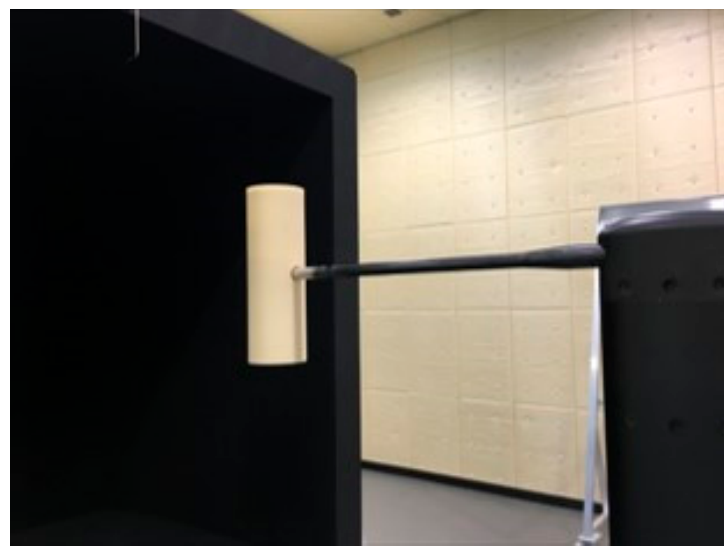
Figure 1. Wind-tunnel setup (cylinder model).